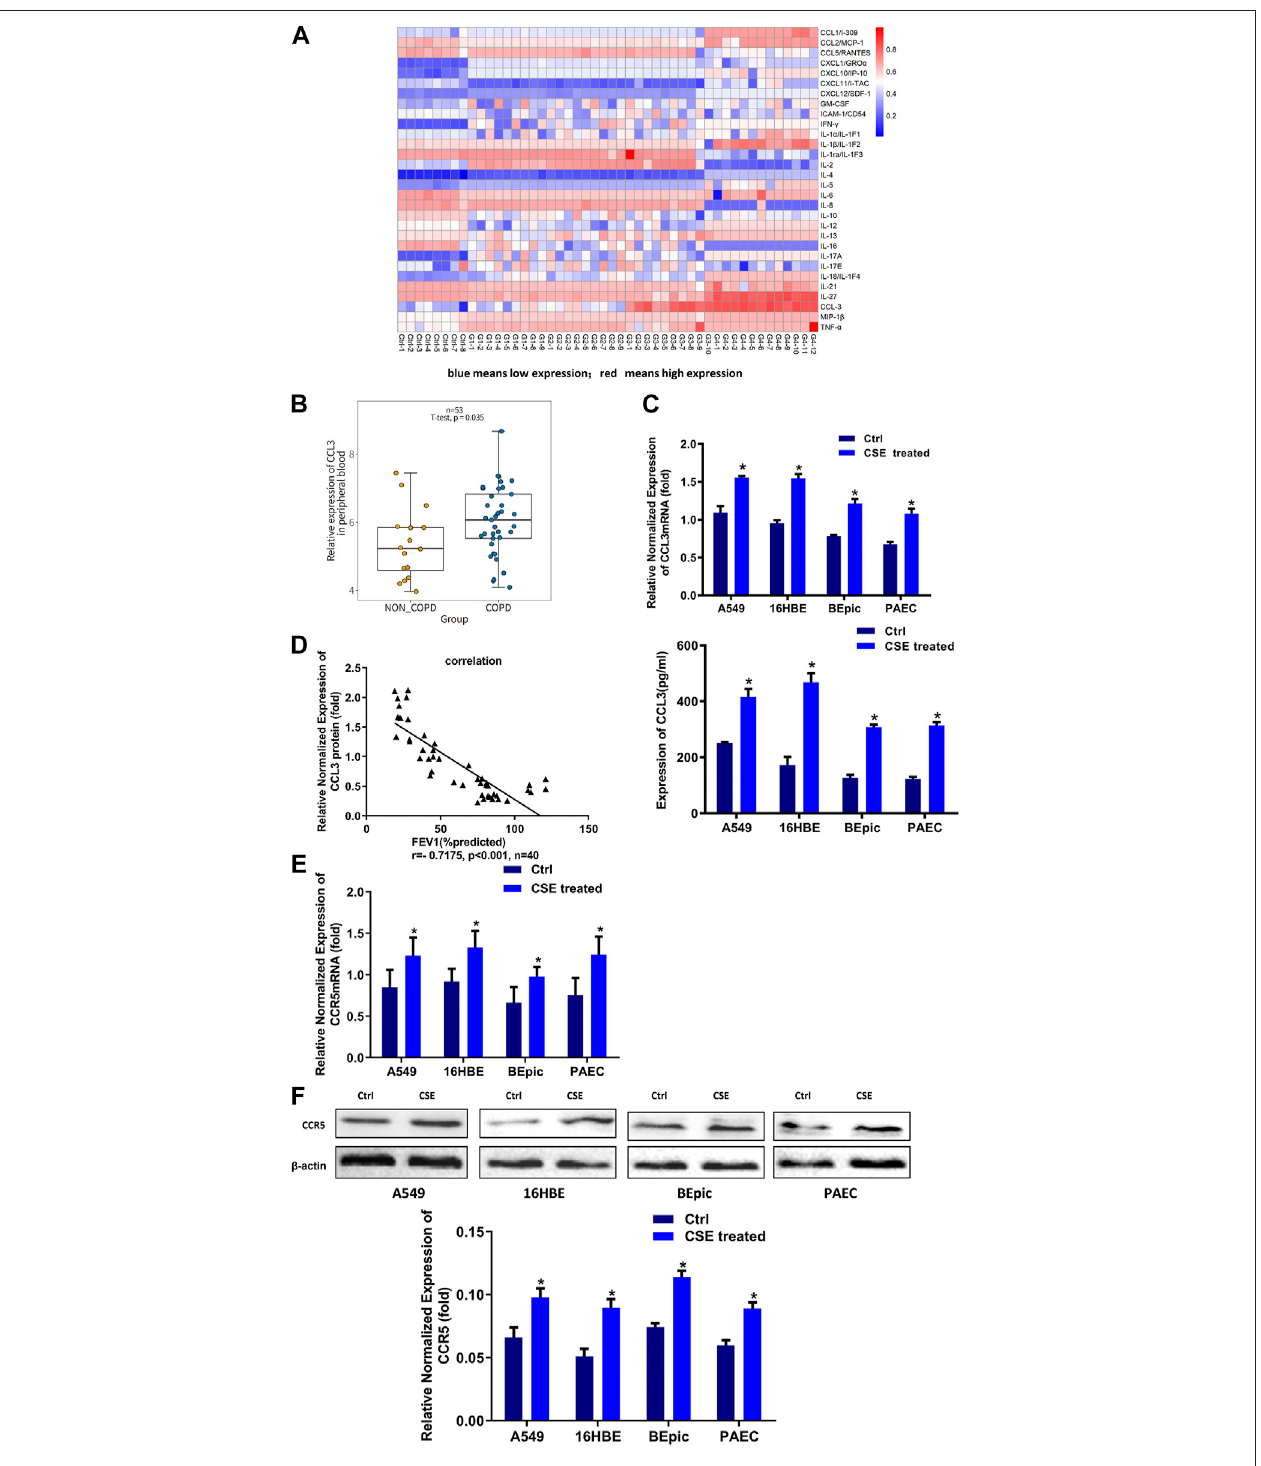
FIGURE 1 | Higher expression of CCL3 in the supernatants of PBMCs cells (A) Human Cytokine Array for the parallel determination of relative levels of cytokines and chemokines in the supernatants of PBMCs cells. Downregulated proteins are shown in blue, and upregulated proteins are shown in red, as the mean of all specimens included ( n (cid:2) 48). non-smokers: Ctrl-1 to Ctrl-8, GOLD 1:G1-1 to G1-9, GOLD2: G2-1 to G2-9, GOLD3:G3-1 to G3-10, GOLD4:G4-1 to G4-12 (B) ExpressionofCCL3inno-COPDand COPDpatients inthehumanGEOdatabase( n (cid:2) 53) (C) Real-timePCRassayswereperformedin16HBE, A549,BEpic,and PAECcellstodetectCCL3mRNAexpressionbeforeandafterCSEtreatment. n (cid:2) 3,* p < 0.05,vs.thecontrolgroup(leftpanel).Theexpressionlevelswerenormalizedto